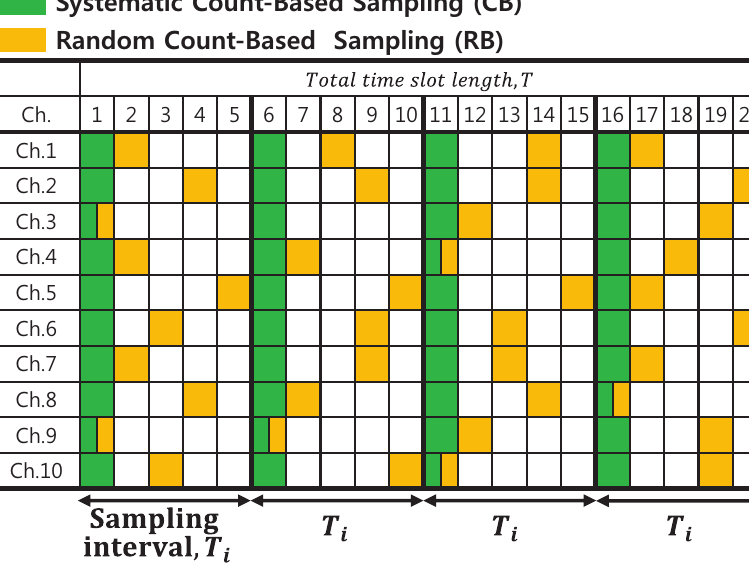
Figure 7. Uniform sampling technique concept and process for the CB and RB